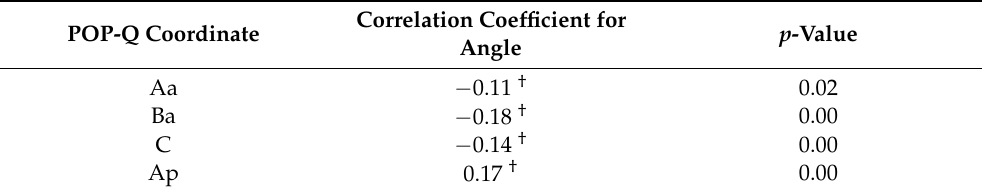
Table 3. Correlation between translabial ultrasound (TLUS) and pelvic organ prolapse quantification (POP-Q) system ( n =